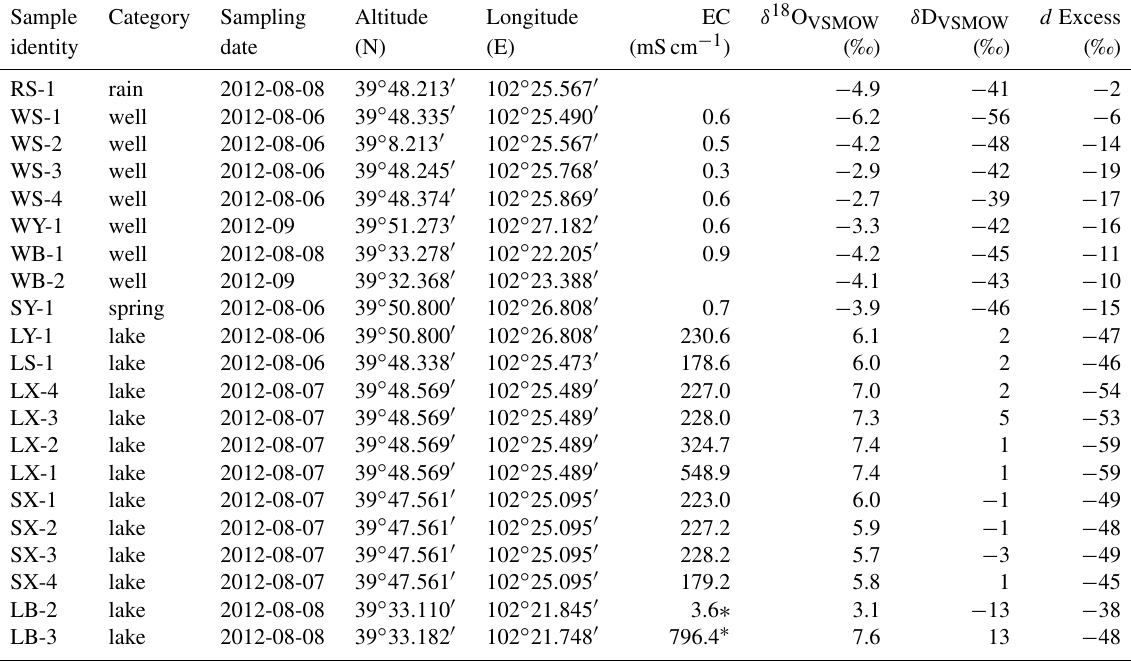
Table 2. The sampling location and data and EC, δ 18 O and δ D values of water samples from lakes, wells and spring in the BJD.